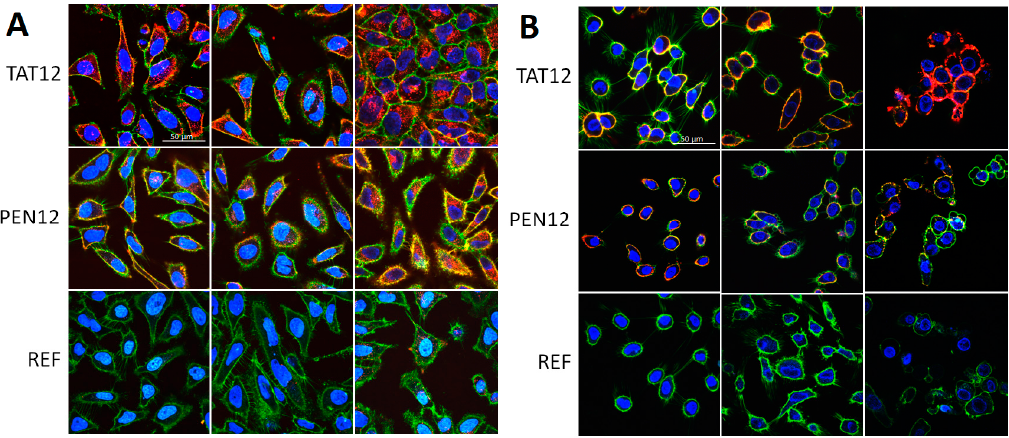
Figure 5. Incubation of HeLa cells with fluorescently labeled polymer–peptide conjugates for 1, 2, or 4 h at concentration 50 μ M (of CPP) at 37 °C ( A ) or 4 °C ( B ). The first row corresponds to TAT12 conjugate, the second to PEN12 conjugate, and the third to control polymer REF . Conjugates are labeled with fluorescent dye Dy633 (colored red), nuclei are stained with Hoechst 33258 (colored blue) and cell membranes were stained with CellMask Green (colored green).